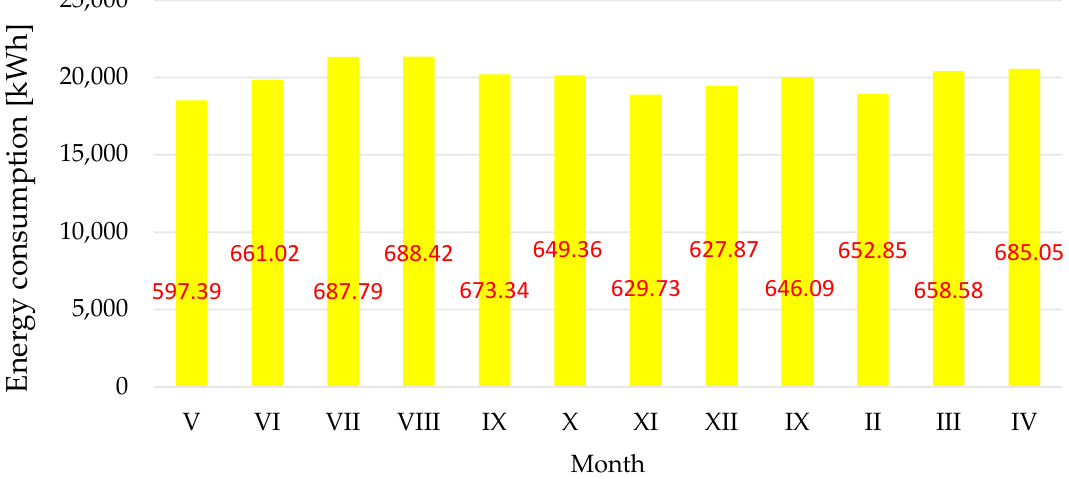
Figure 2. Monthly energy consumption per point. The red color marks the average monthly energy consumption.